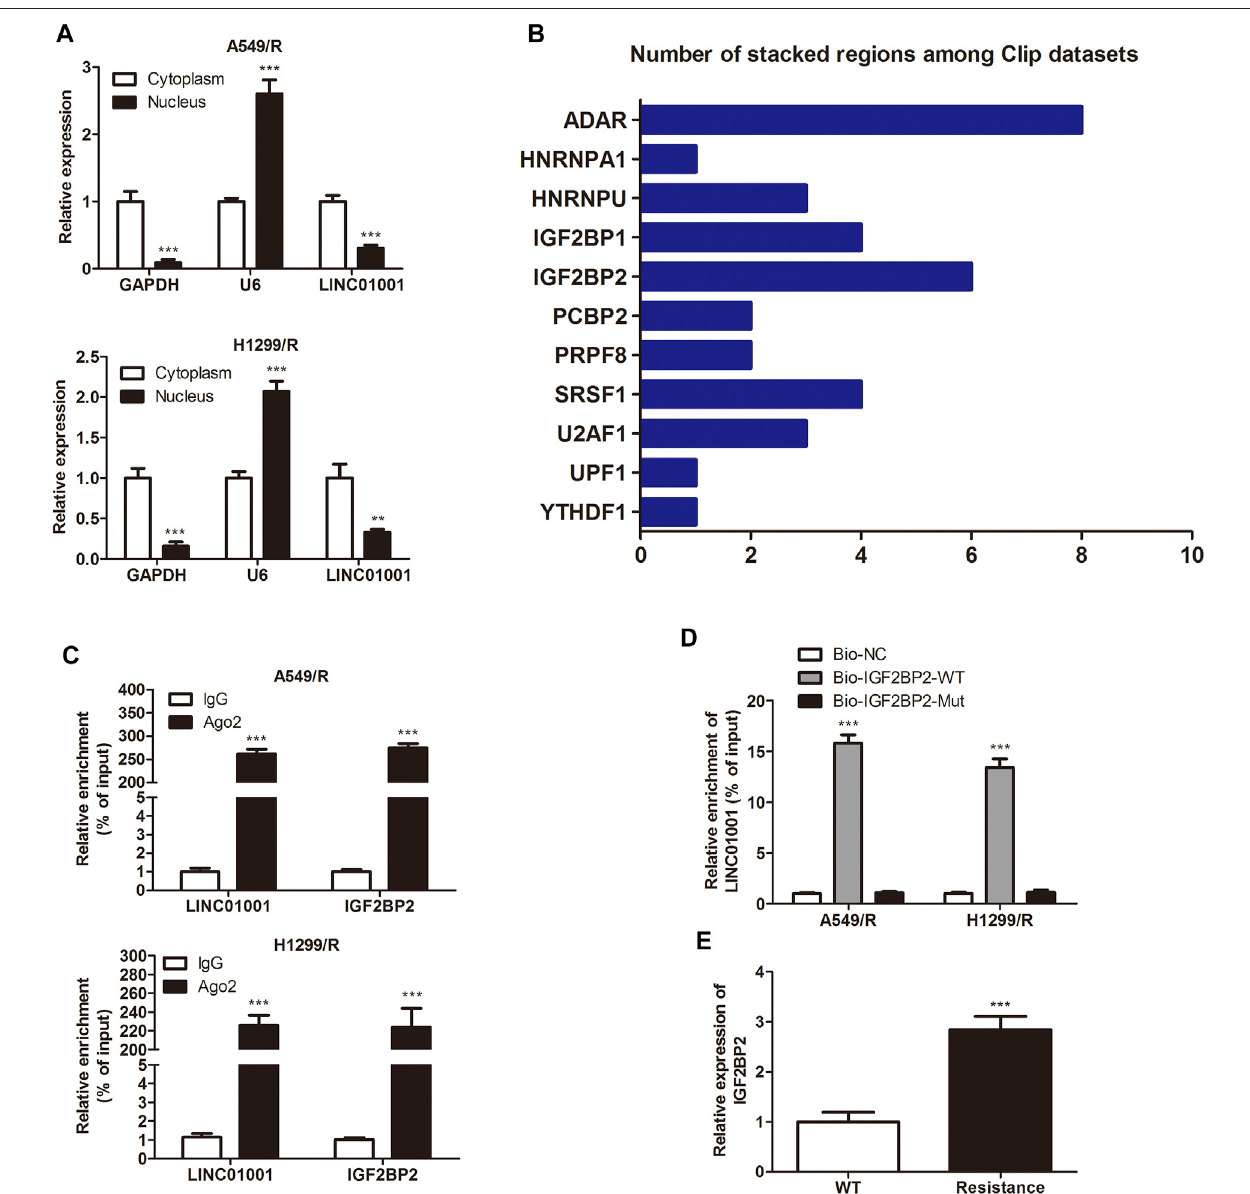
FIGURE 4 | LINC01001 interacts with IGF2BP2. (A) Subcellular fractionation evaluated the localization of LINC01001 in crizotinib-resistant NSCLC cells. ** p < 0.01,*** p < 0.001 vs Cytoplasm (B) BioinformaticsanalysisindicatedLINC01001interactedwithIGF2BP2. (C) RIPassayevaluatedtheinteractionbetweenLINC01001 and IGF2BP2 in drug resistant cells. *** p < 0.001 vs IgG group (D) RNA pulldown assay con fi rmed the interaction between LINC01001 and IGF2BP2. *** p < 0.001 vs Bio-NC group (E) RT-qPCR was conducted to assess the level of IGF2BP2 in crizotinib-resistance NSCLC cells. *** p < 0.001 vs WT group. Error bars represent SD. Data represent three independent